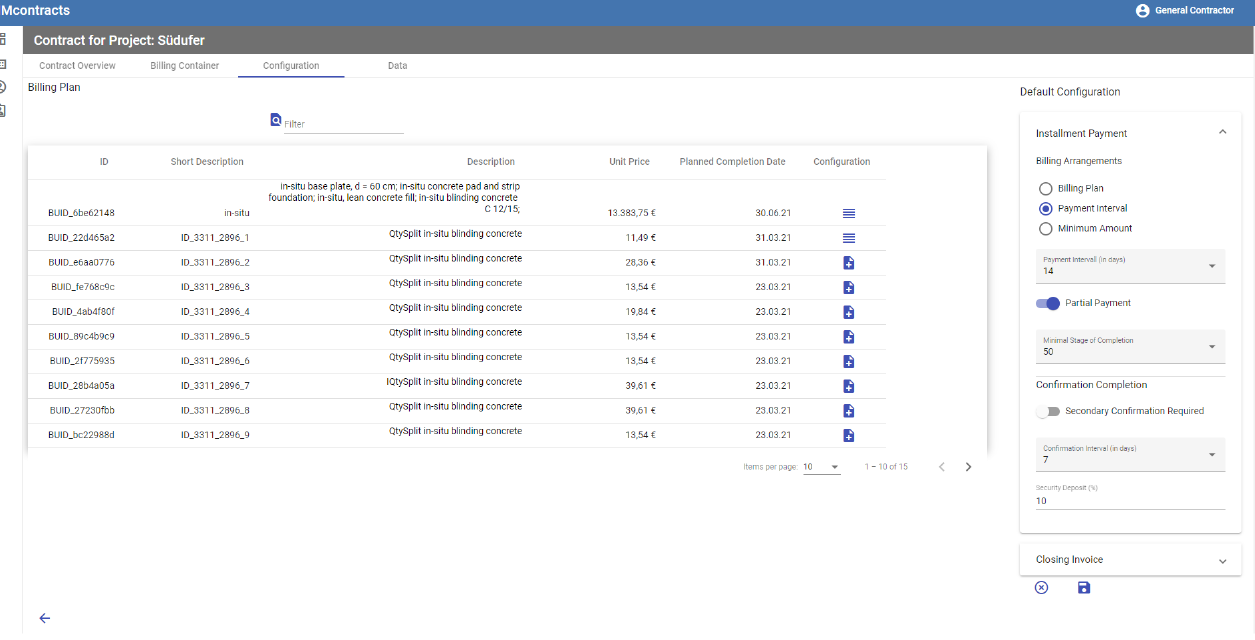
Figure 11. Listed billing units and configuration of billing